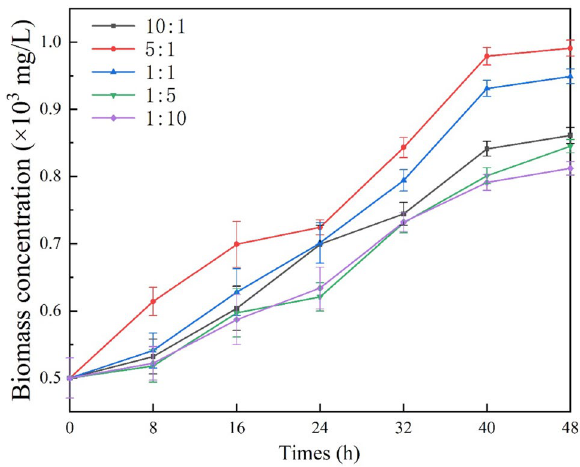
Figure 3. The promotion of the biomass concentration. Consortia with algae/sludge 10:1, 5:1, 1:1, 1:5 and 1:10 (donated as R1 to